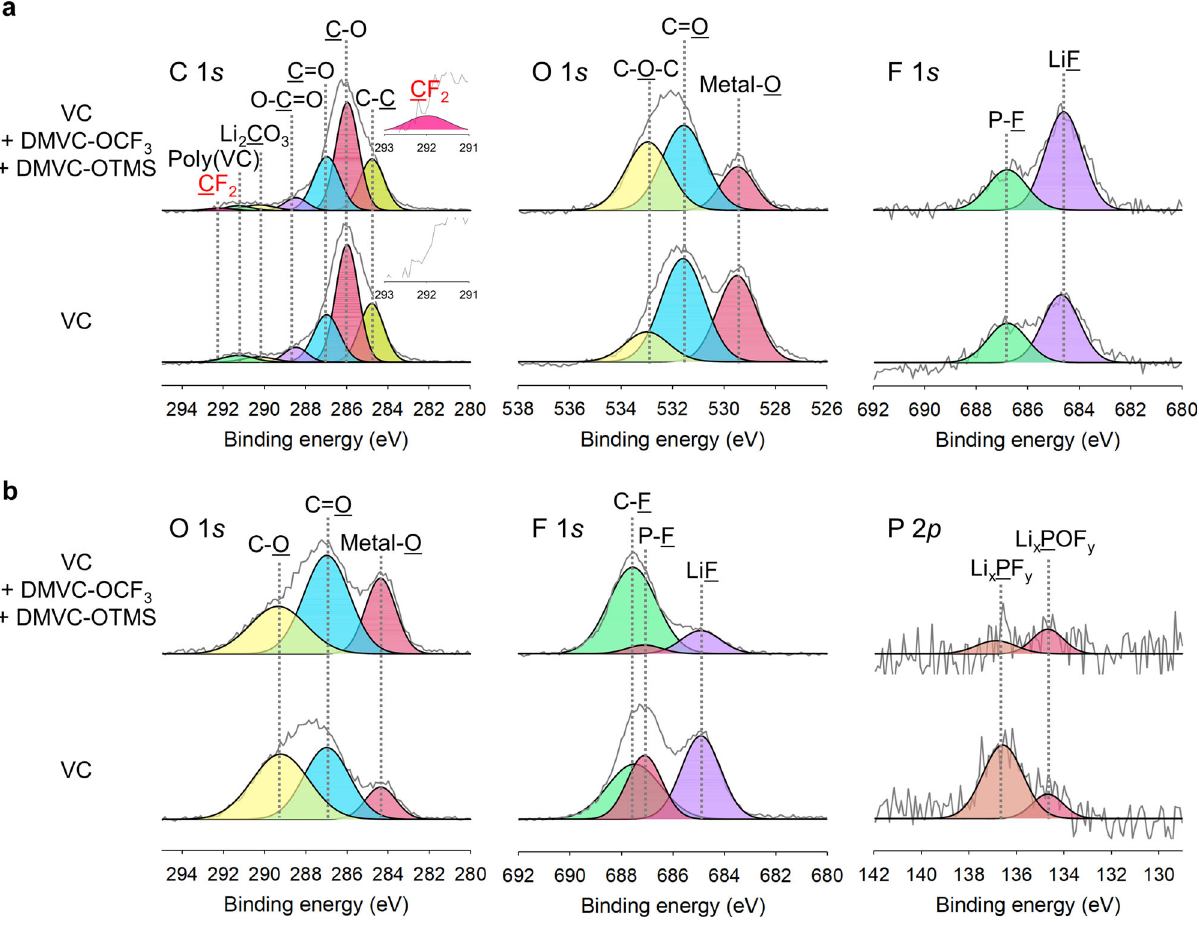
Fig. 6 XPS spectra of Si – C anodes and NCM811 cathodes after precycling. a C 1 s , O 1 s , and F 1 s spectra for Si – C anodes after precycling of NCM811/Si – C full cells with VC + DMVC-OCF 3 + DMVC-OTMS and VC. b , O 1 s , F 1 s , and P 2 p spectra for NCM811 cathodes obtained from NCM811/Si-C full cells